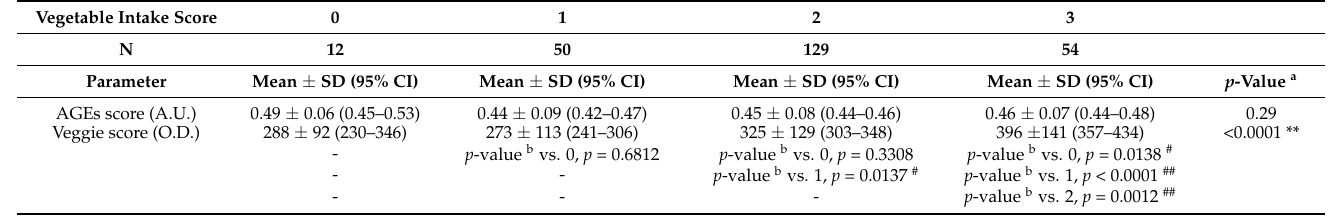
a Comparison among 4 vegetable intake score groups by one-way ANOVA. b Comparison between vegetable intake score groups by post hoc unpaired t -test. Significance levels at 1% ( p < 0.01) **, 5% ( p < 0.0083) # , and 1% ( p < 0.0016) ## . CI, confidence interval.